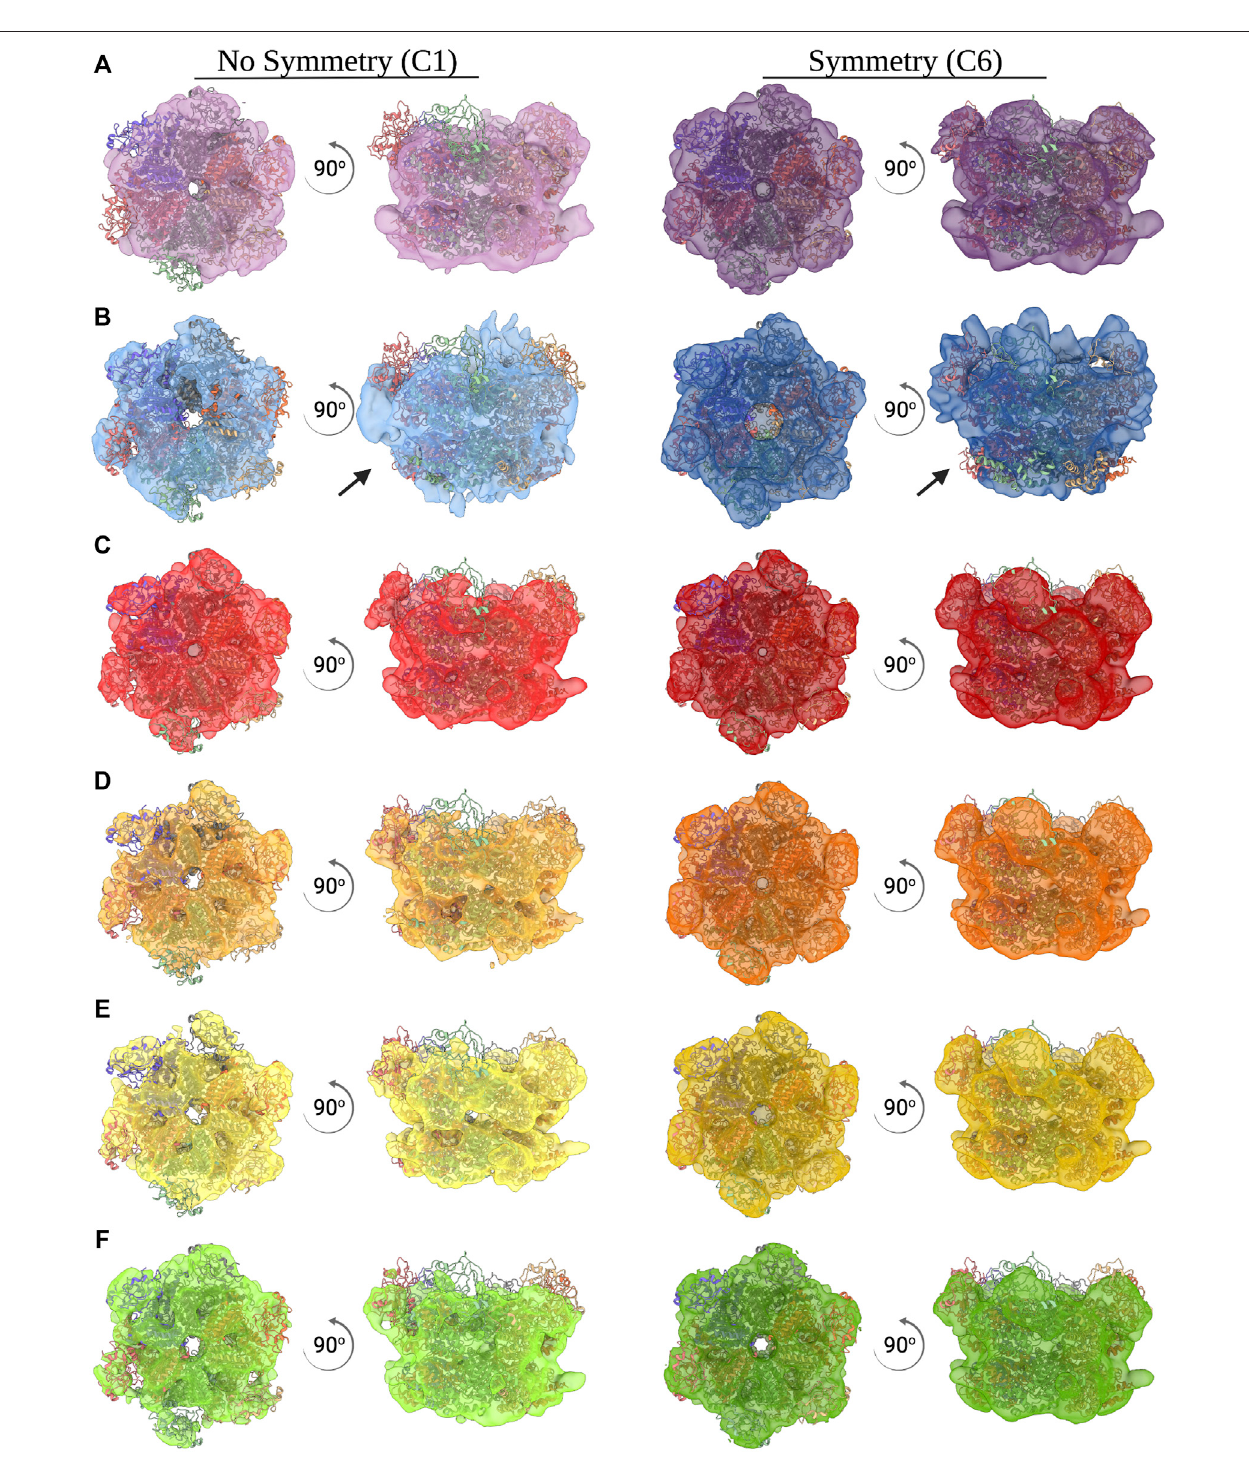
FIGURE 3 | Ab initio reconstructions of CDC48A. (A – F) Top and side view of an ab initio reconstruction of CDC48A with (right, dark color) and without (left, light color)C6symmetryimposed.AllreconstructionsfromtheACSMBdataset (A) ,theeBICdataset (B) ,optimizeddataset1 (C) ,optimizeddataset2 (D) ,optimizeddataset 3 (E) , and optimized dataset 4 (F) are superimposed with the structural homologue p97 (PDB entry 5FTN). Arrows indicate poorly reconstructed regions as a result of preferential orientation.